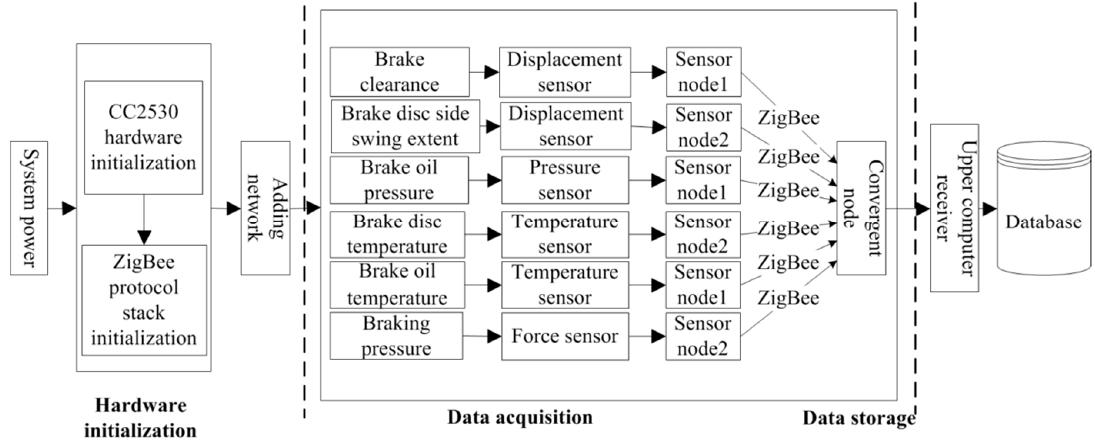
Figure 3. Internet of Things (IoT) perception layer structure.